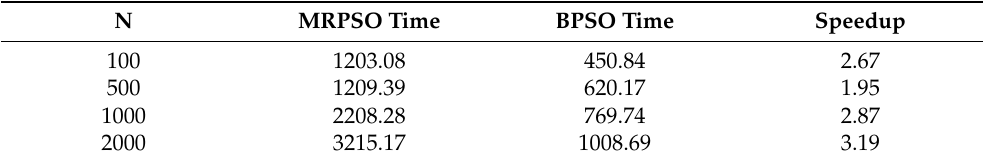
Table 5. MRPSO and BPSO running time and speedup on f 4